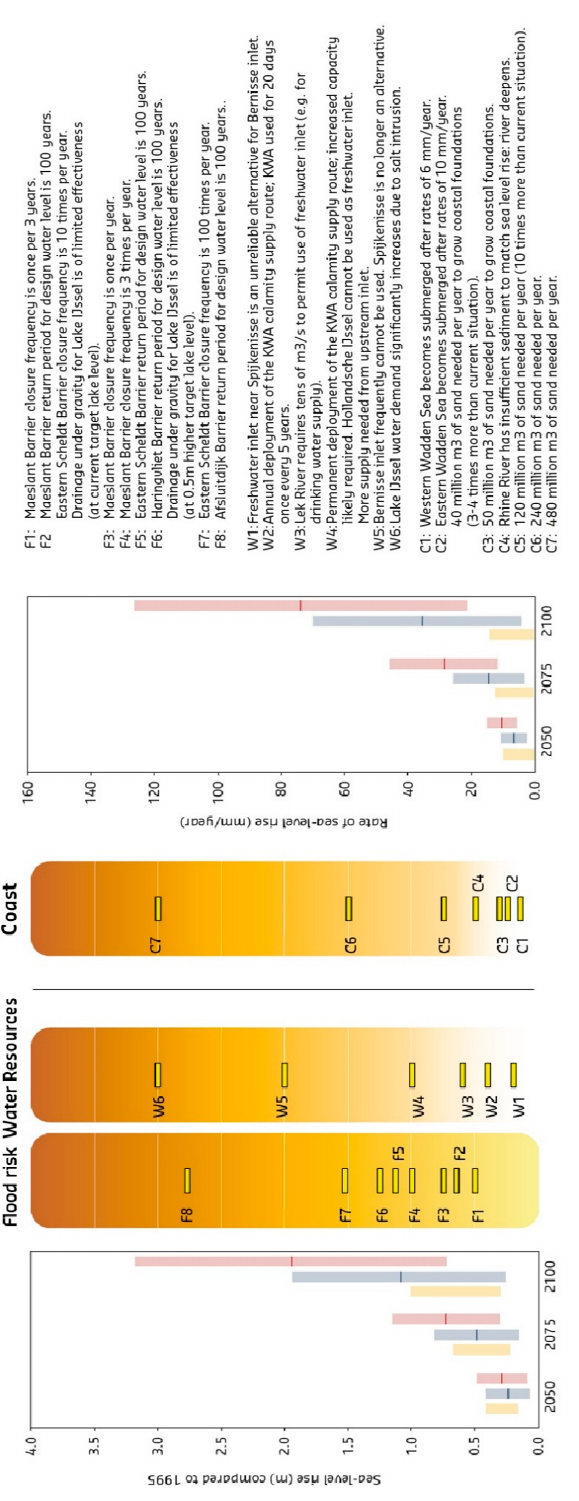
Figure 3. The consequences of accelerated SLR on measures related to flood risk, water management, and coastal maintenance. Left panel is sea-level height, right panel is SLR rate. The colored bars represent different SLR scenarios for the Netherlands: yellow = Delta scenarios 2014, blue: RCP 4.5, and pink: RCP8.5. The horizontal yellow bars in the three central columns represent the tipping points in present flood risk, water management, and coastal management policies, referred to by codes and explained below the diagram (Reprinted with permission from Haasnoot et al., 2020